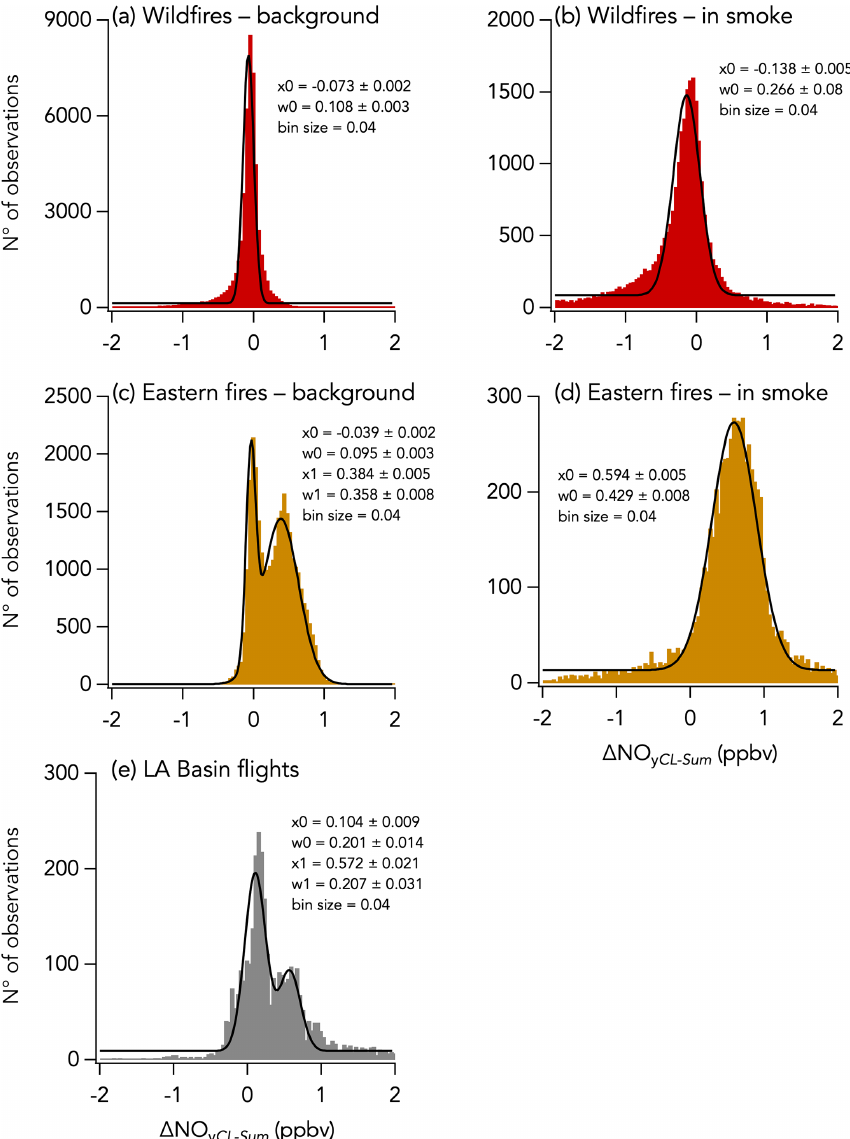
Figure 11. Histograms of (cid:49) NO y CL-Sum for three sampling periods during FIREX-AQ with the wildfires sampling period in red, the eastern fires sampling period in yellow, and the Los Angeles (LA) Basin flights in grey. Further separation was made between in-smoke measure- ments (b, d) and background air measurements (a, c, e) . Parameters of the Gaussian fit to the histogram are indicated in each panel, with x 0 and w 0 being the central value and the width of the fit, respectively. Note that in panels (c) and (e) a double Gaussian was fitted to the histogram and that the parameters for the second mode are given by x 1 and w